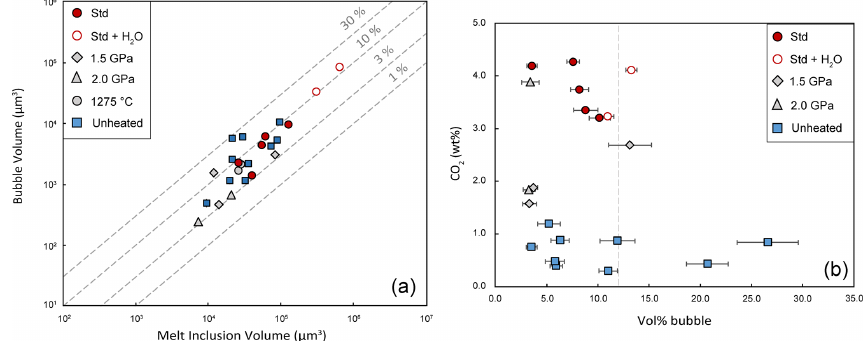
Figure 10. (a) Plot of bubble volumes (µm 3 ) as a function of melt inclusion volumes (µm 3 ) for both the unheated melt inclusions and the melt inclusions used in the homogenization experiments (same symbols as in Fig. 9). Isovolumetric lines corresponding to bubble/melt inclusion volume ratios of 1%, 3%, 10%, and 30% are also shown. Bubble volumes were calculated from the bubble diameters assuming a spherical shape. Melt inclusion volumes and associated errors were computed following the method described by Moore et al. (2015). Most of the melt inclusions have complex shapes that were approximated by an ellipsoidal shape. (b) Plot of the total CO 2 contents measured in the homogenization experiments and the CO 2 contents measured in the glasses of unheated melt inclusions as a function of bubble sizes (in vol%). The dashed line at 12vol% is the threshold used by Hanyu et al. (2020) to separate homogeneous from heterogeneous